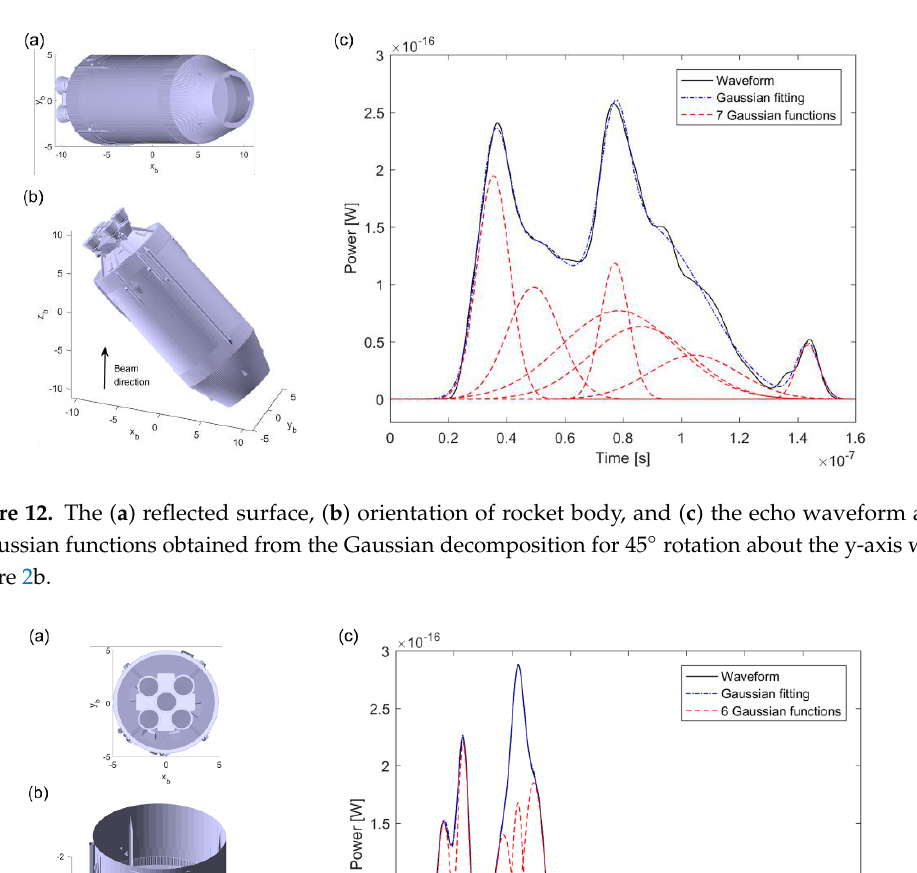
Figure 11. The ( a ) reflected surface, ( b ) orientation of rocket body, and ( c ) the echo waveform and 7 Gaussian functions obtained from the Gaussian decomposition for -45° rotation about the y-axis w.r.t. Figure 2b.